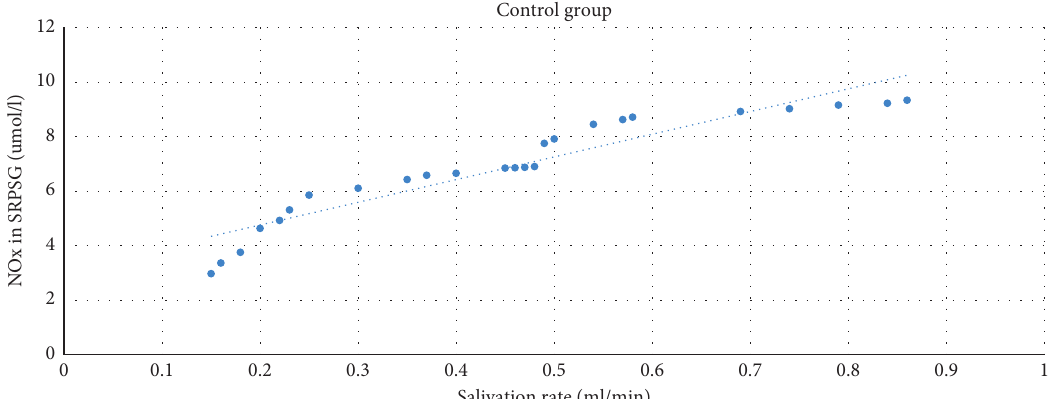
Figure 3: The correlation between the NOx level in SRPSG and the salivation rate among patients in the control group.